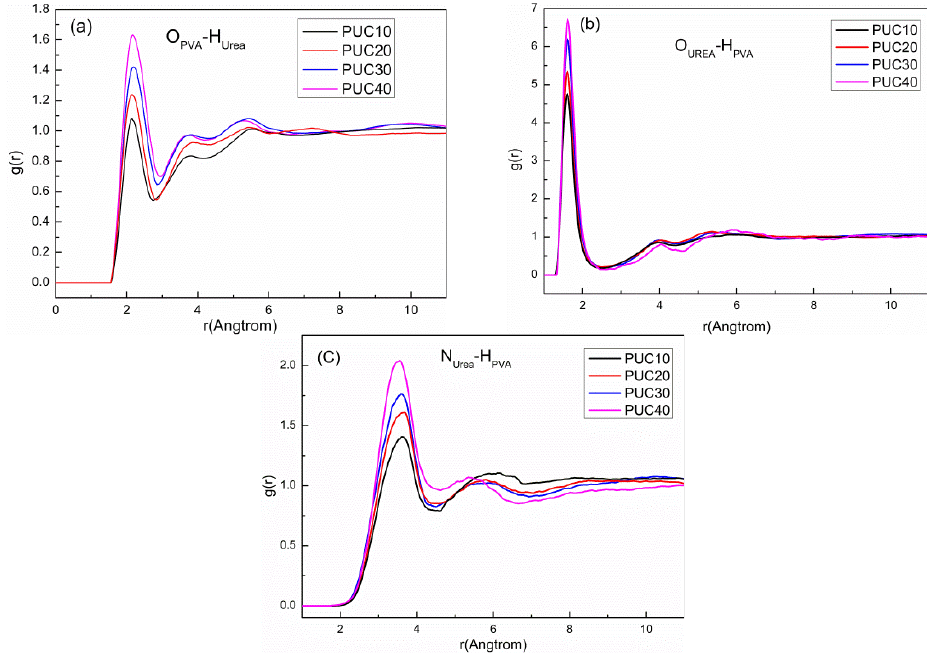
Figure 6. RDFs between ( a ) O PVA - H Urea , ( b ) O Urea - H PVA and ( c ) N Urea - H PVA .